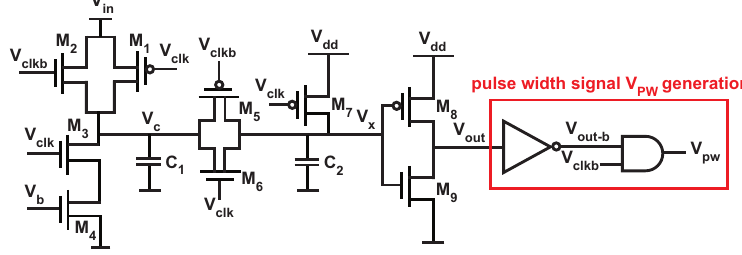
Figure 2. Transistor level design of the proposed VTC [27].